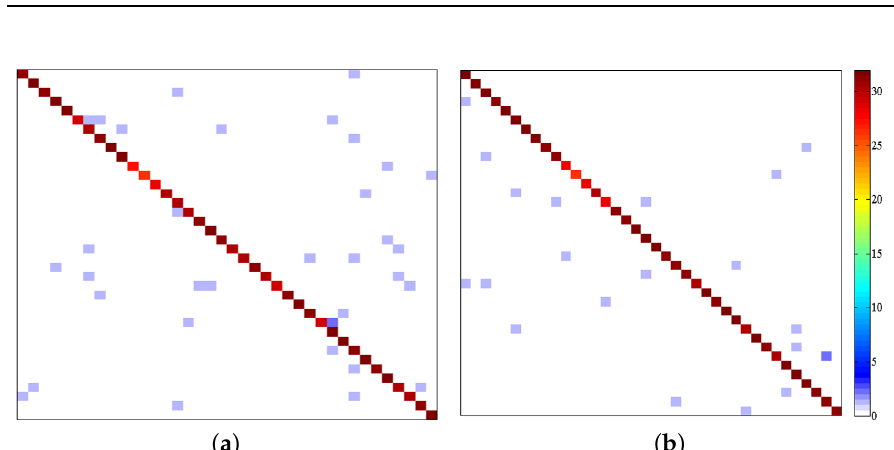
Figure 7. Patterns of confusion on Extended YaleB. ( a ) Tanh. ( b )